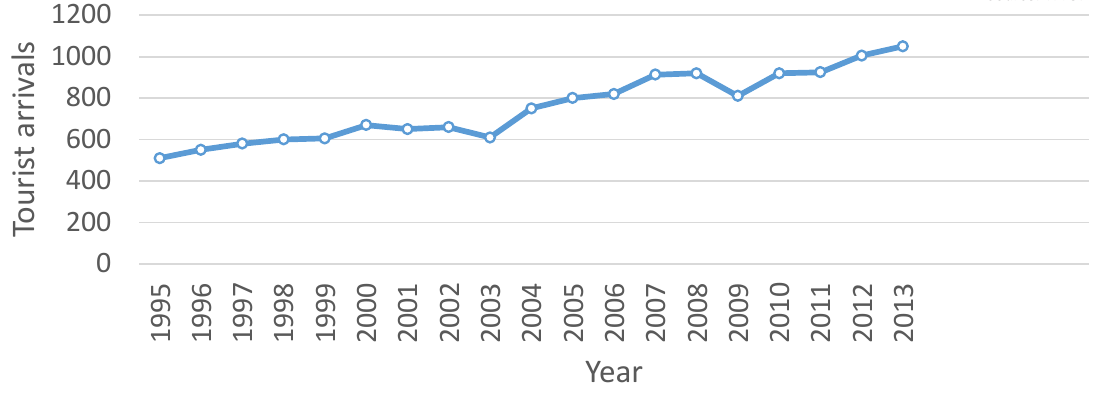
Figure 1. Development of tourism between